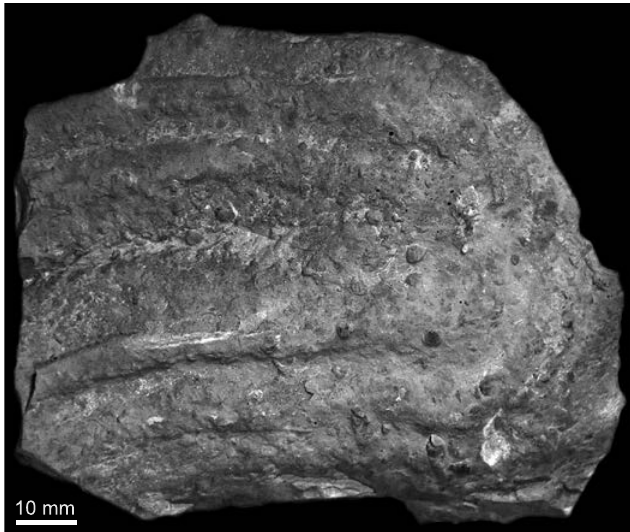
Fig. 5. Complex actively filled horizontal structure Scolicia strozzii (Savi and Meneghini, 1850) MZM Ge 32949, from Velká nad Veličkou, Czech Republic,